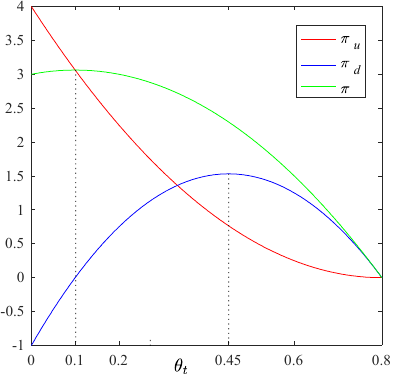
Figure 7. Profits of entities in Scenario U.